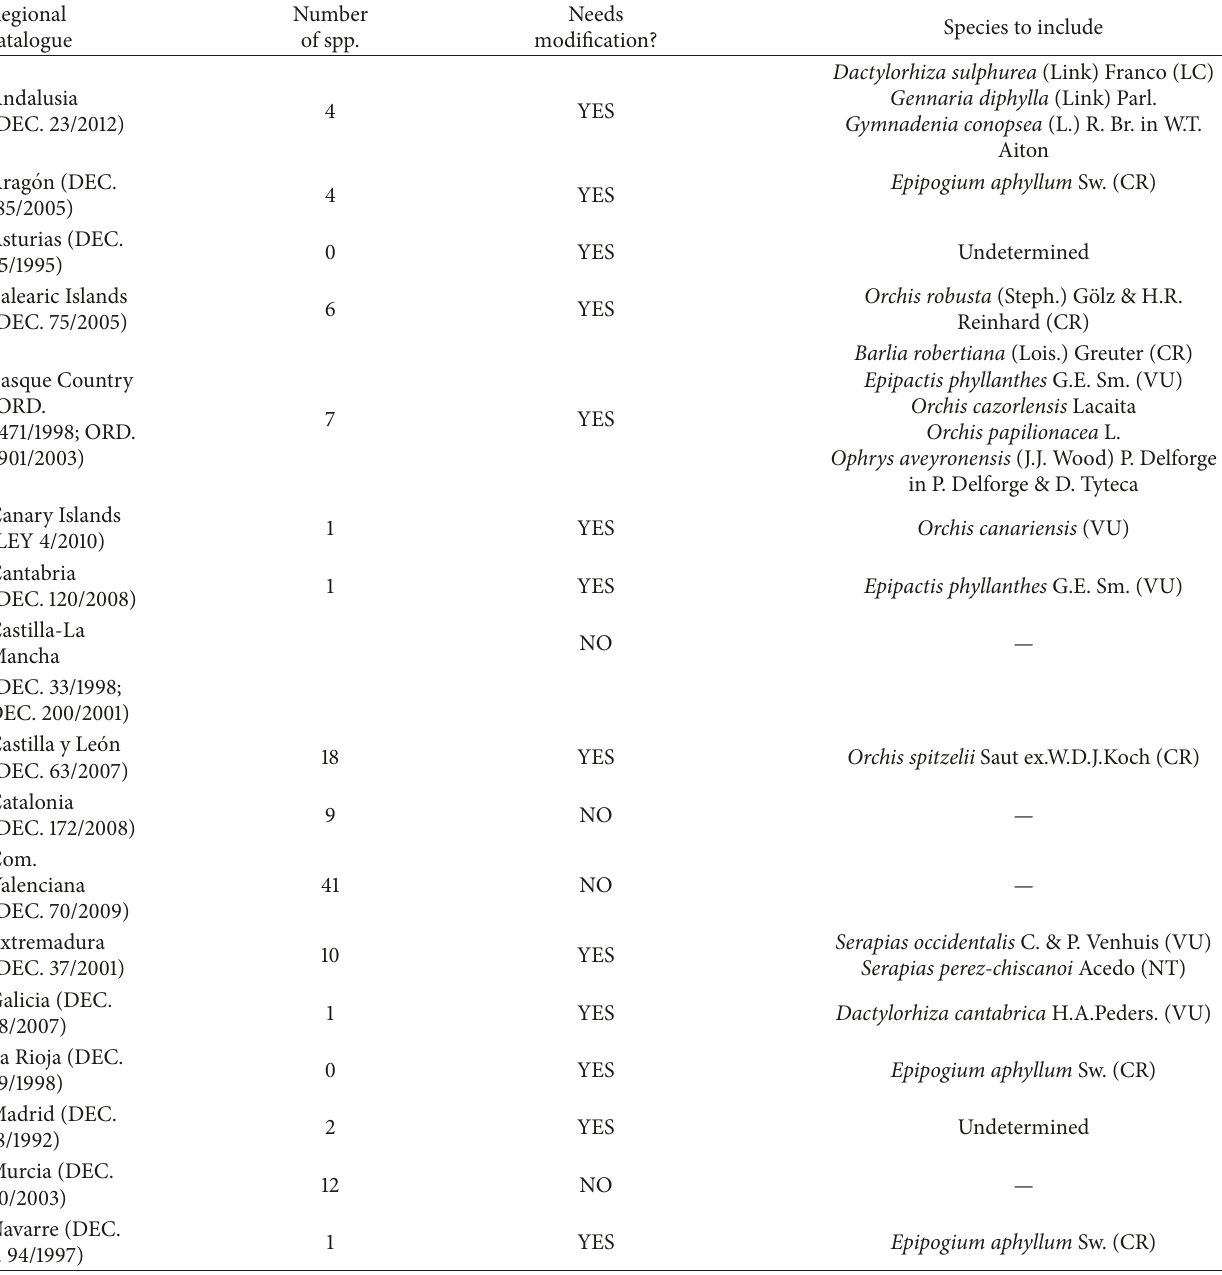
Table 22: Number of species included in each regional catalogue, indicating in each case the most recent legislation that regulates it, as well as the need of an urgent modification, the minimum species to include in it, and their figure of protection—if it exists—according to the 2010 Red List of Spanish Vascular Flora [86] (Table